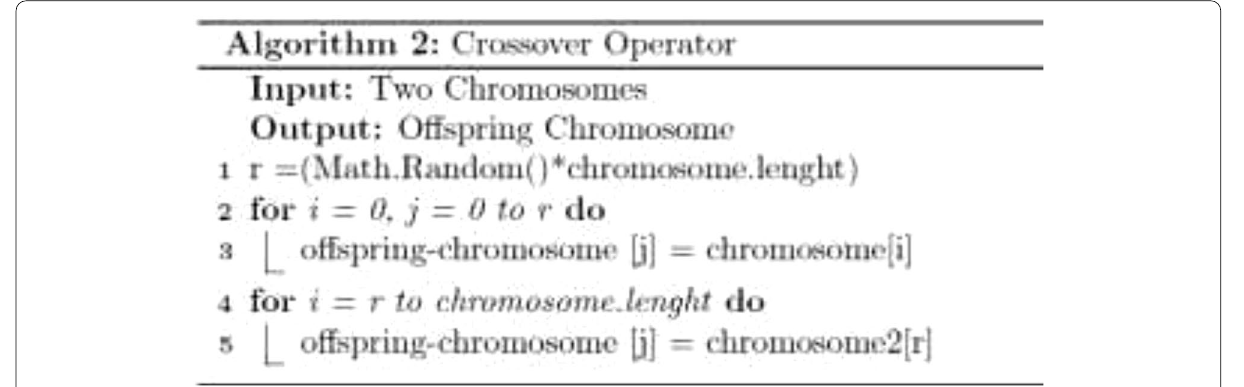
Fig. 4 Crossover Operator for the GA part of the eh-GA-PSO Algorithm